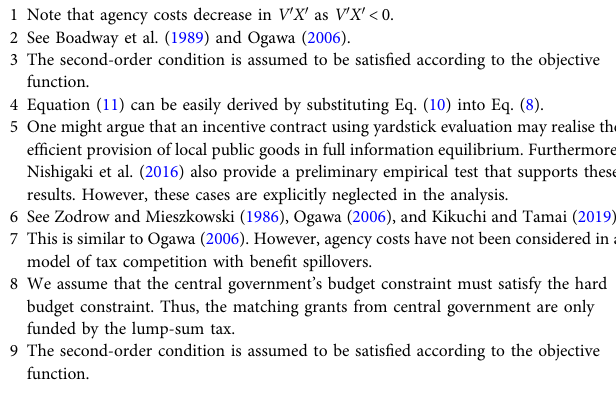
Table 2 Some simulated values for β , n and V 0 X 0